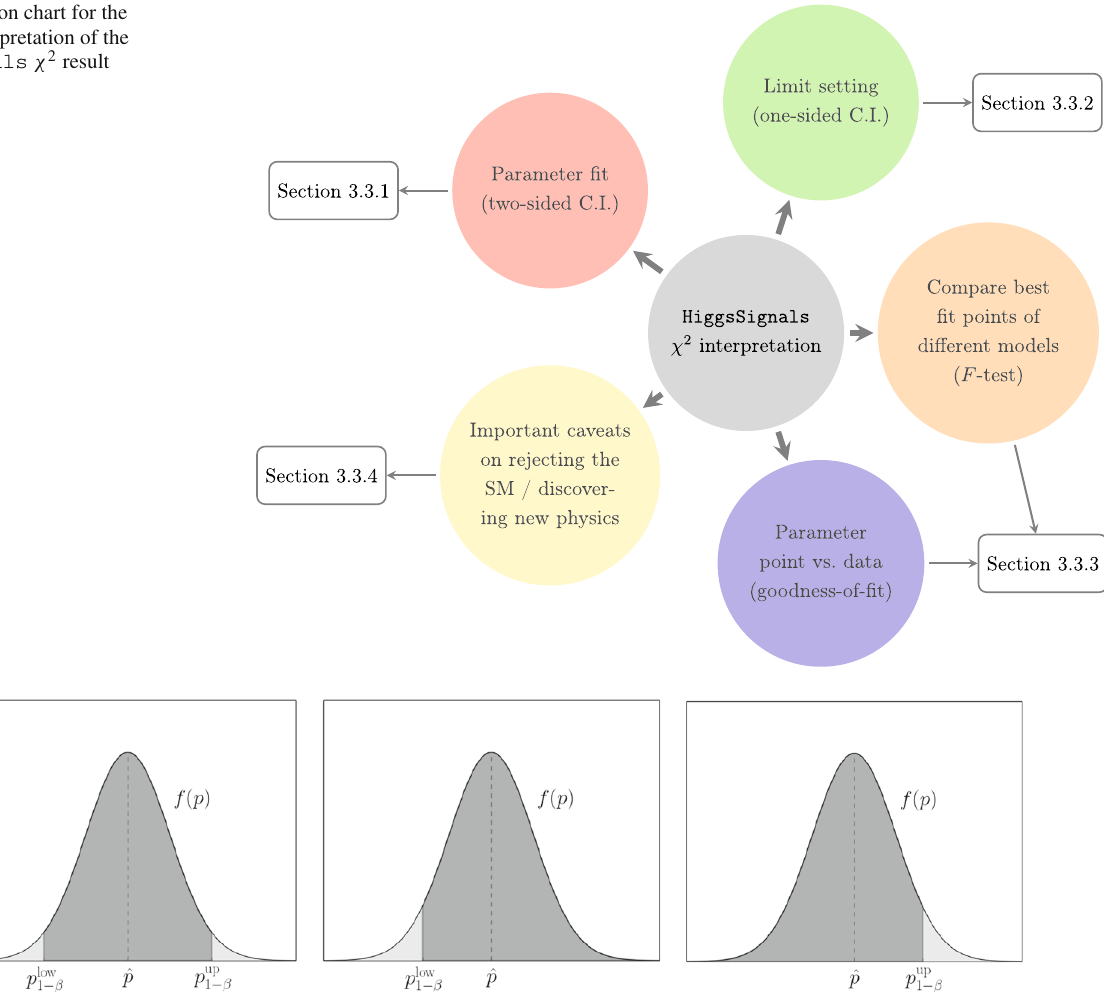
Fig. 3 Decision chart for the statistical interpretation of the HiggsSignals χ 2 result